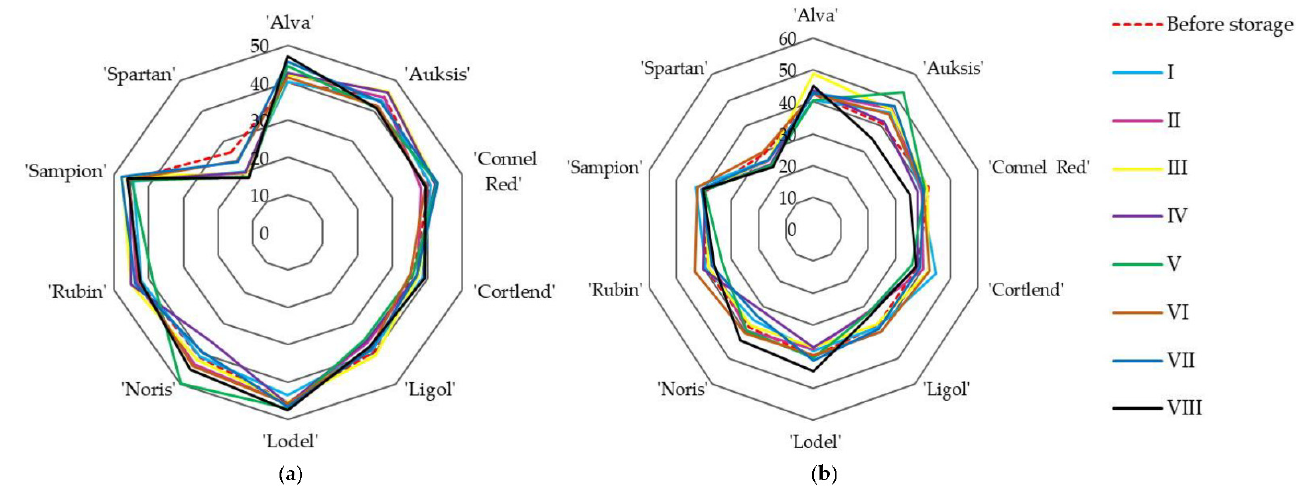
Figure 2. Changes in coordinates measured in NBS units in apple peel before and after storage in CA: ( a ) color saturation (C*) co-ordinate; ( b ) lightness (L*) co-ordinate.